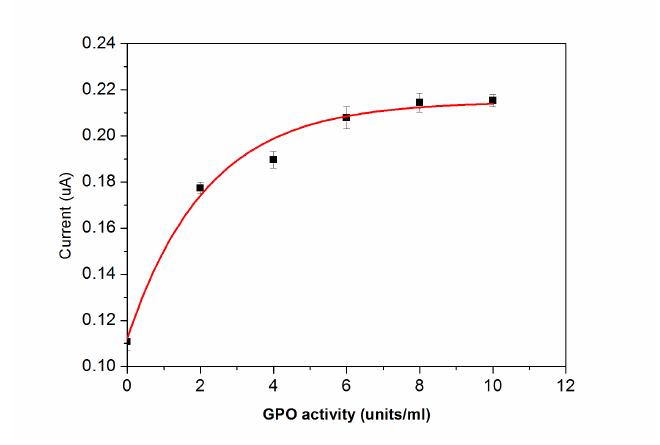
Figure 8. Effect of immobilized glyercol 3-phosphate oxidase on the working electrode in bovine